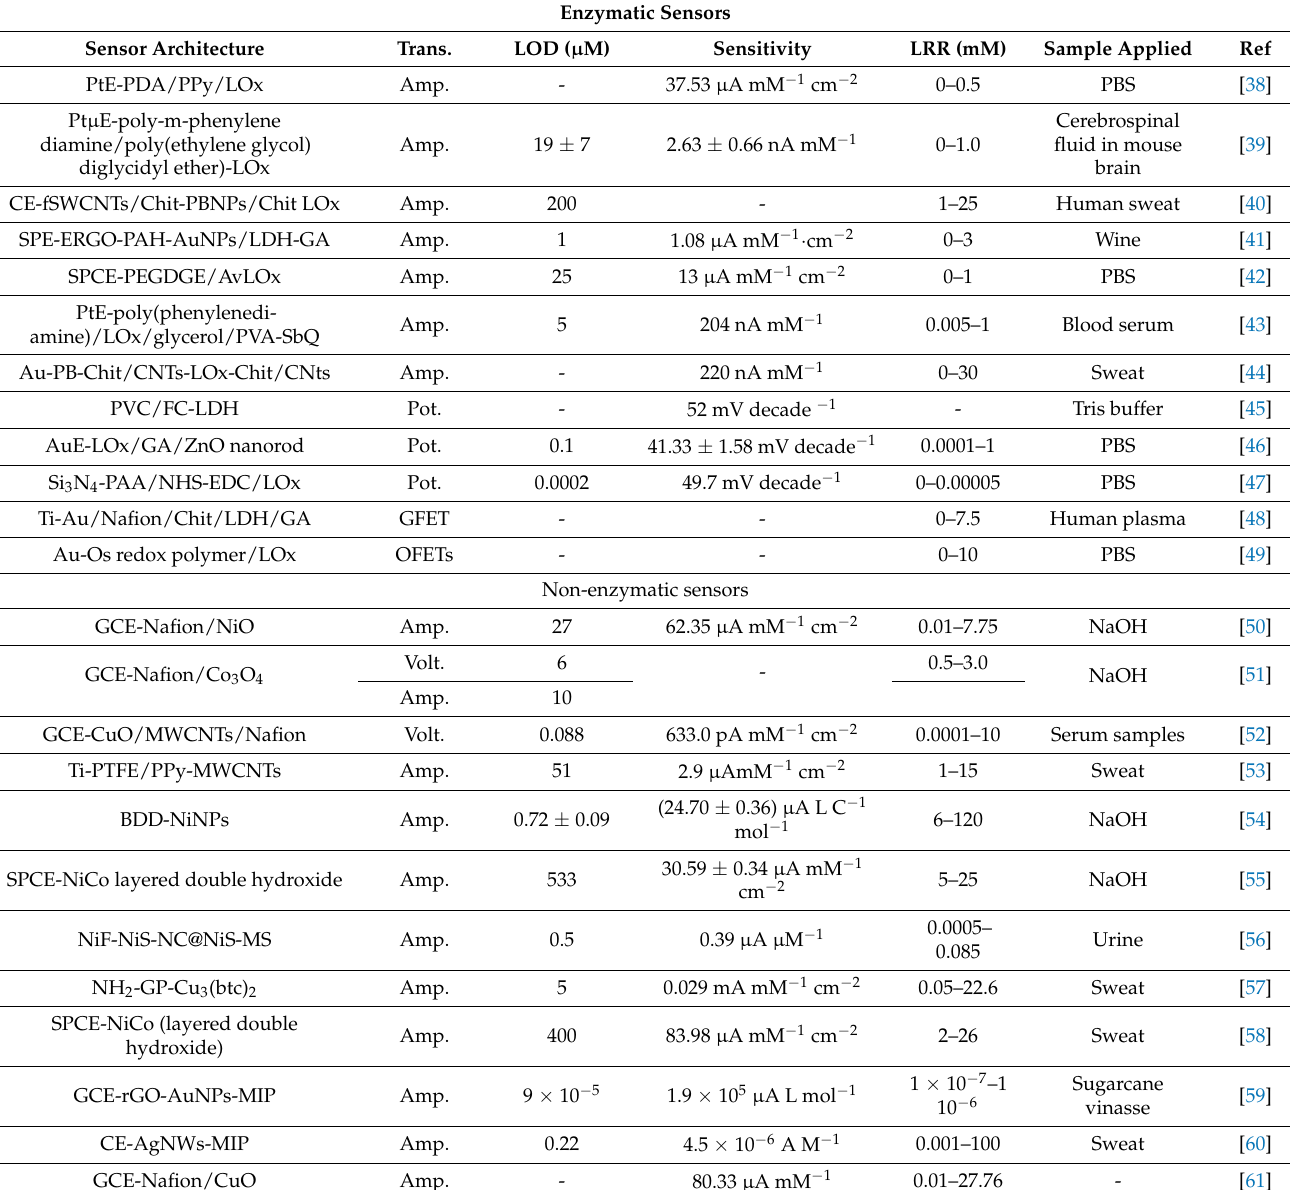
Table 1 offers an insightful picture of how the state of the art for lactate electrochemical (bio)sensors is currently drawn in the literature. Table 1. Relevant lactate electrochemical (bio)sensors according to their transduction